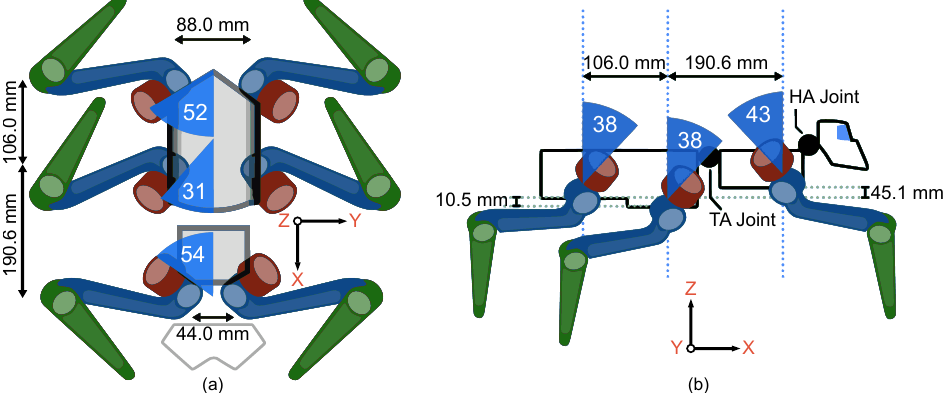
Figure 5. Dimensions of the developed concept for a bio-inspired robot morphology (Section 4.1) that is based on the dimensions of the dung beetle (Section 3.4). The leg-mounting configurations with a top view of the functional model and ALPHA with ( a ) transverse dimensions and mounting roll angles [ φ ] for each pair of legs, as well as ( b ) a side view with midsagittal dimensions and pitch angles [ θ ].